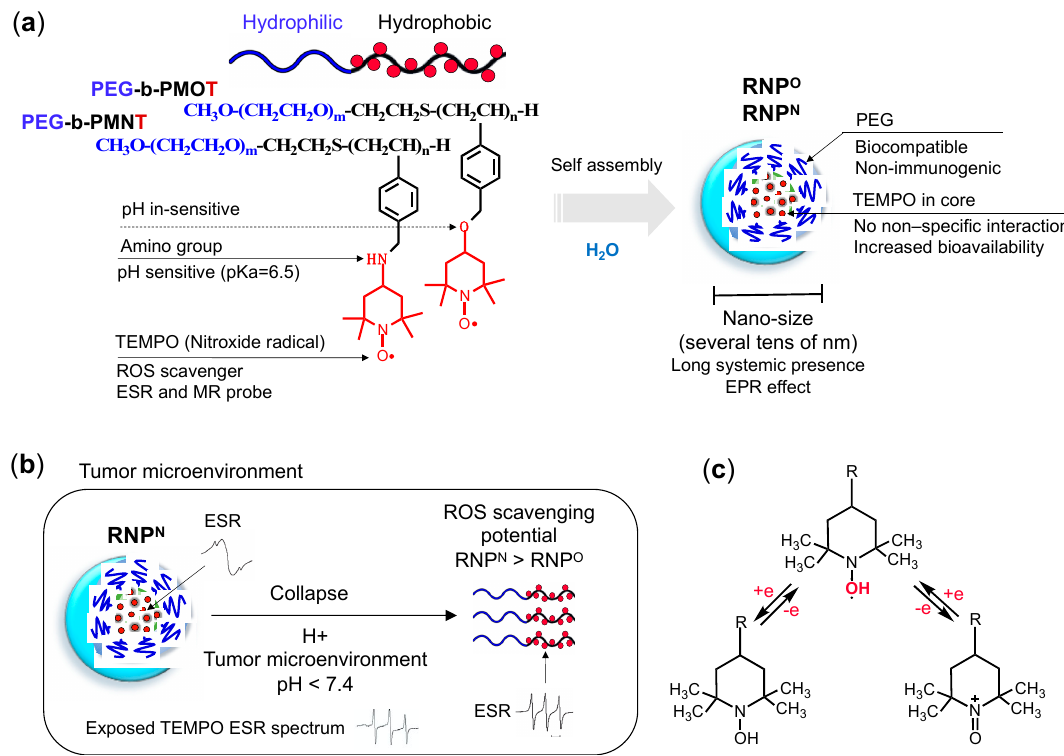
Figure 2. ( a ) Design and structure of antioxidant amphiphilic block copolymers, PEG- b -PMOT and PEG- b -PMNT, which self-assembles in aqueous media to form nano-sized micelles: pH-insensitive RNP O and pH-sensitive RNP N , respectively, used for cancer therapy. ( b ) Illustration showcasing pH-sensitive characteristic of RNP N in the diseased environment (tumor); the amino groups of antioxidant TEMPO moieties in the copolymer (pKa 6.5) is protonated under the low pH in the tumor environment, leading to collapse of RNP N micelle, which enhances its ROS scavenging potential than pH-insensitive RNP O . The exposed radical of TEMPO can be detected by Electron Spin Resonance (ESR) as sharp triplet peaks, but when it is in the core of stable RNP N , the ESR signal of TEMPO broadens. At low pH, due to disassembly of RNP N , TEMPO radical is exposed and displays characteristic sharp triplet peaks of TEMPO. This ESR sensitive characteristic is essential for the pharmacokinetics studies of RNPs. ( c ) Reduction and oxidization reaction equations of TEMPO.